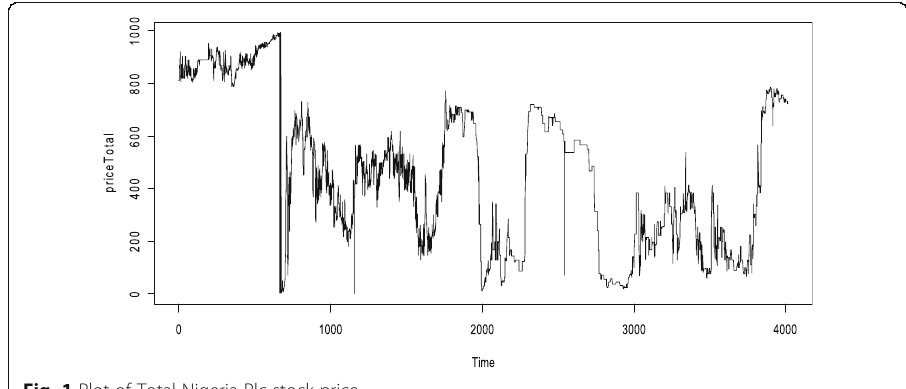
Fig. 1 Plot of Total Nigeria Plc stock price